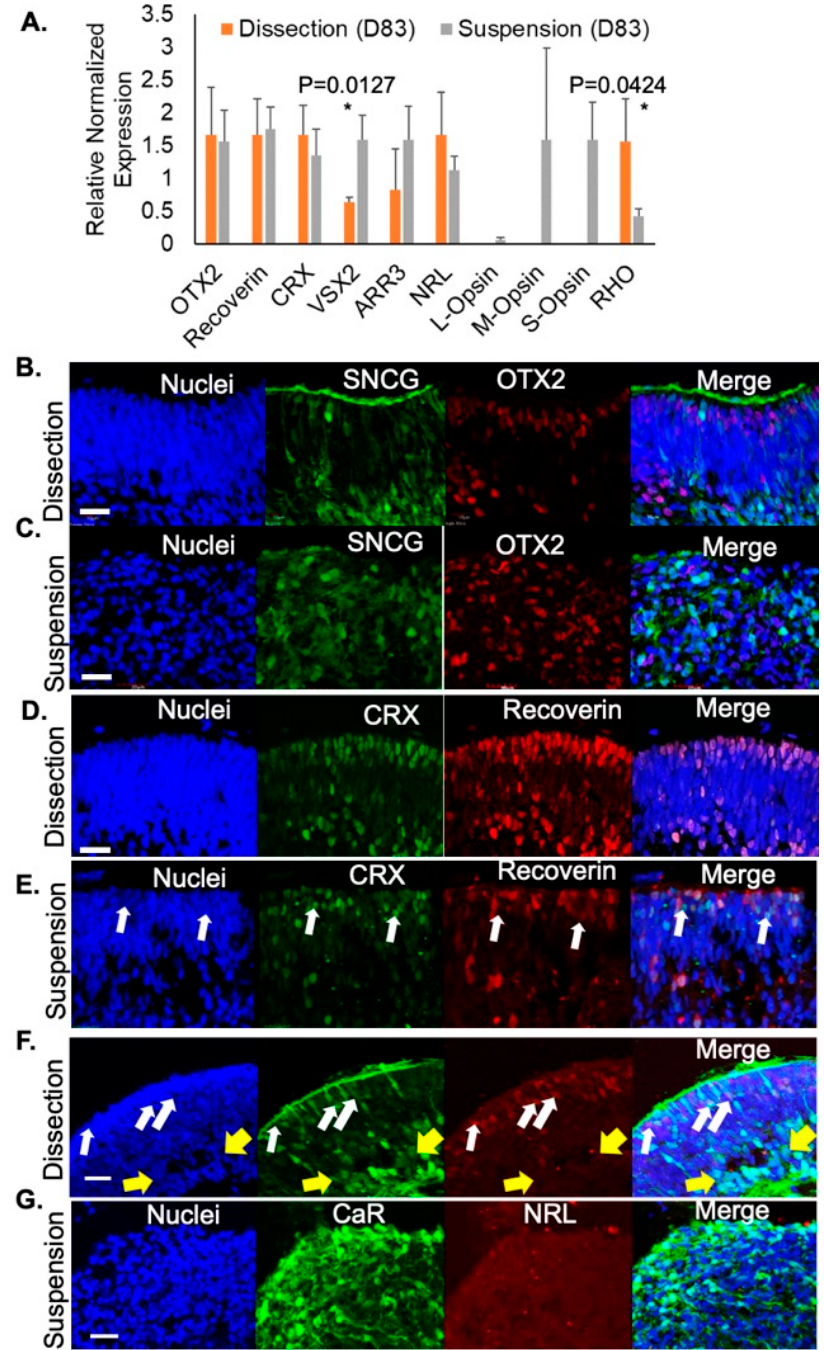
Figure 3. The onset of photoreceptor differentiation was identified in retinal organoids. ( A ) RT-qPCR on D83 retinal organoids showing expression of photoreceptor-specific markers. Representative images showing SNCG (green) and OTX2 (red) expression from D100 retinal organoids grown using the ( B ) dissection ( C ) or suspension method. ( D – G ) Representative images from D100 retinal organoids differentiated using the ( D , F ) dissection method or the ( E , G ) suspension method. White arrows highlight NRL+ rods. Yellow arrow highlights formation of the inner retinal layer. Scale bar 20 µ m. * Statistical significance p ≤